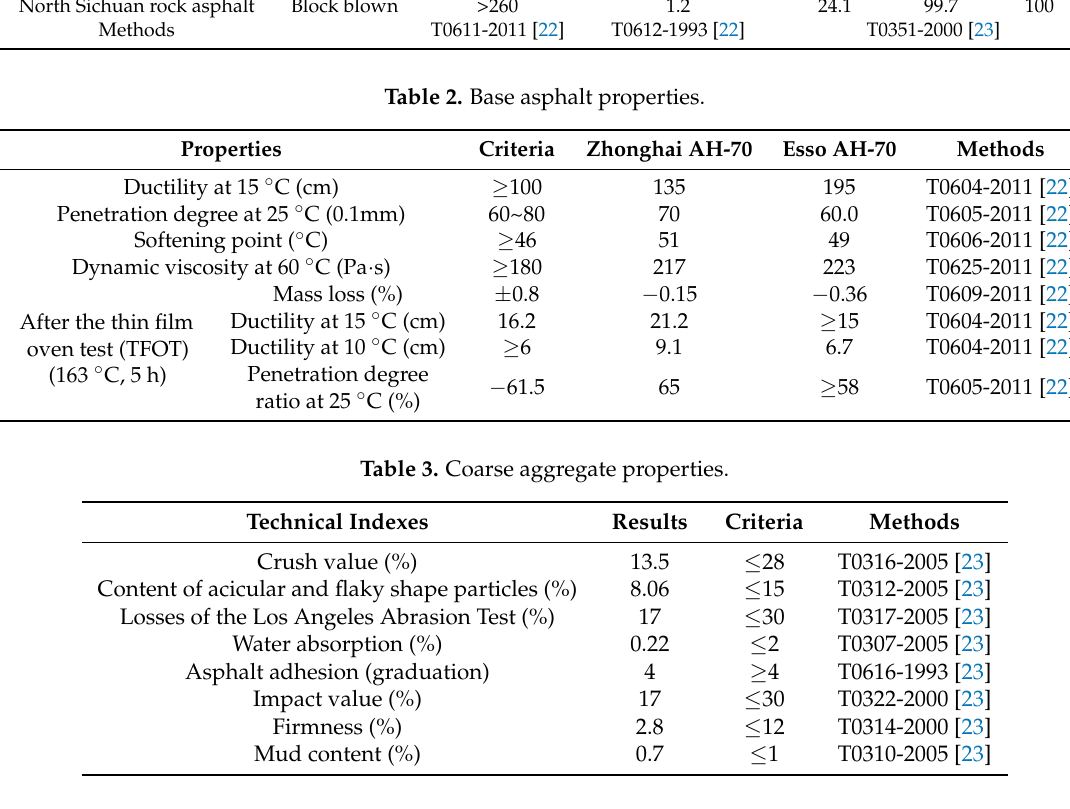
Table 4. Mineral filler properties.